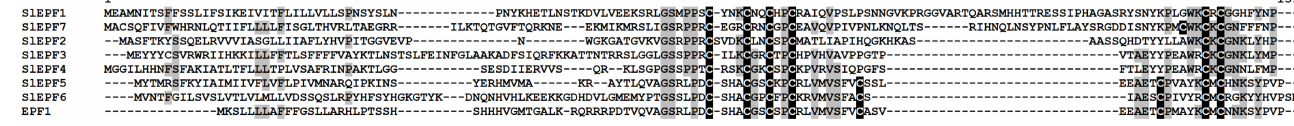
Figure 15. Multiple sequence alignment of S. lycopersicum EPF precursors and A. thaliana EPF1 [51]. Cysteine residues are shaded black, and identical amino acids are shaded